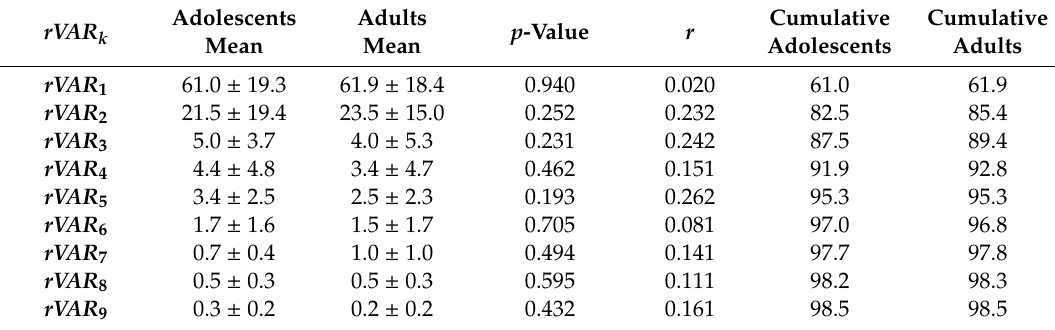
Table 3. rVAR k of adolescents and adults in the di ff erent movement components during the eyes-closed trial. Means ± SD of each group and corresponding p -values are presented. E ff ect sizes ( r ) are displayed according to